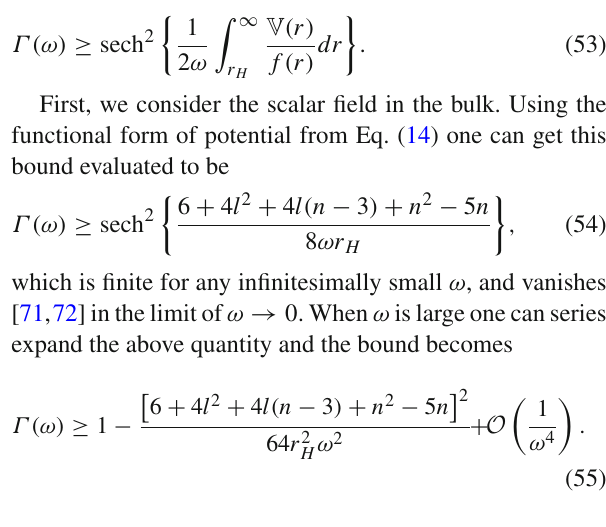
Fig. 2 a Here we plot the bound on the greybody factor with respect to the frequency ω for l = 1, r H = 1 and different values of spacetime dimensionality n . b Here we provide the plot of the bound on the grey- body factor with respect to varying spacetime dimension n for l = 1, r H = 1. The frequency ω = 8 is chosen conveniently. In both of these cases the considered potential corresponds to a scalar field in the bulk and the particular assumption on h is h =